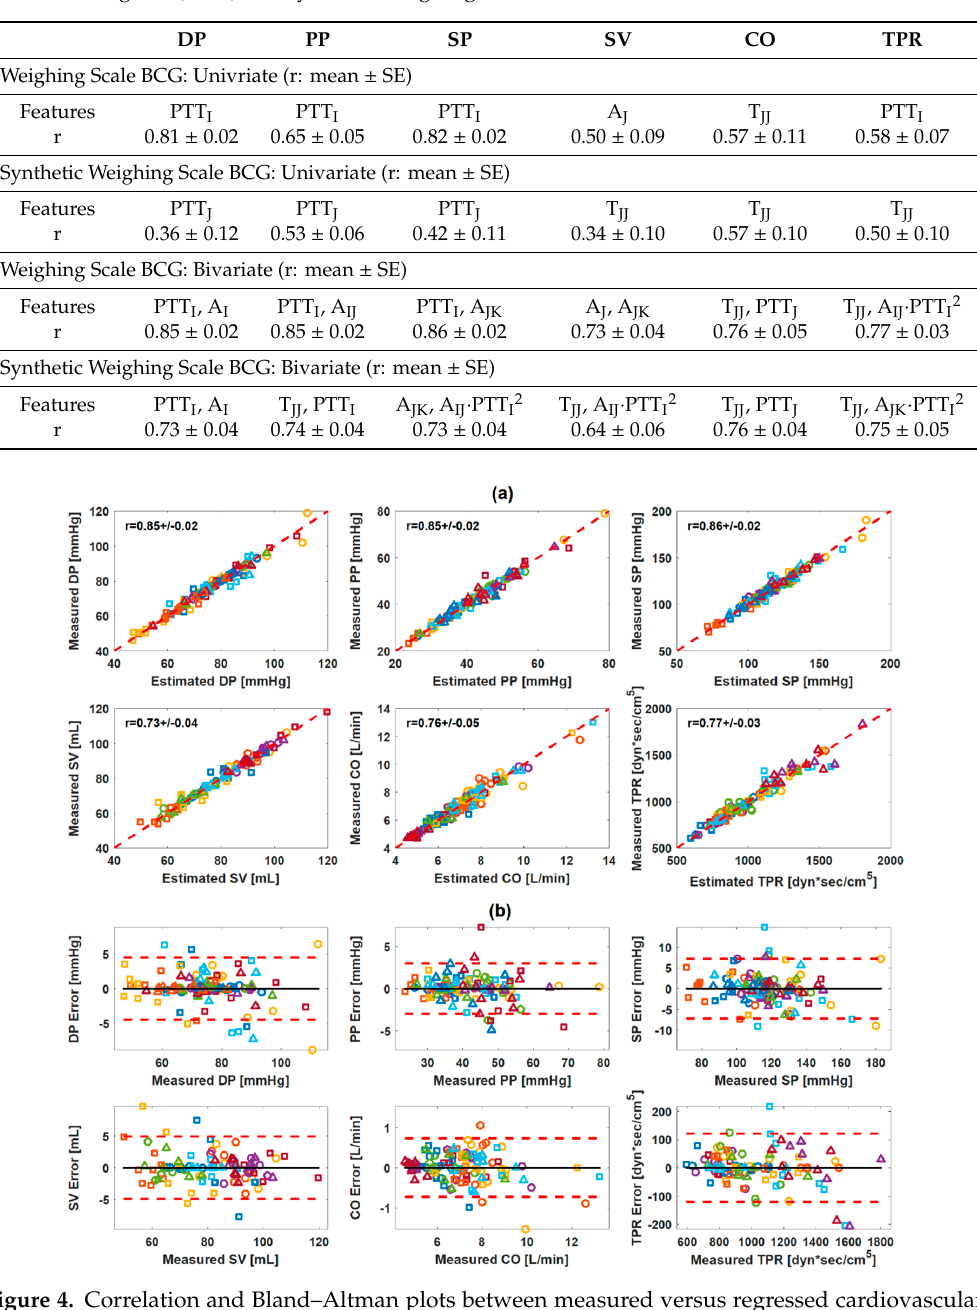
Figure 4. Correlation and Bland–Altman plots between measured versus regressed cardiovascular parameters: weighing scale ballistocardiogram (BCG). ( a ) Correlation plots. ( b ) Bland–Altman plots. Black solid line: bias. Red dashed lines: confidence interval.